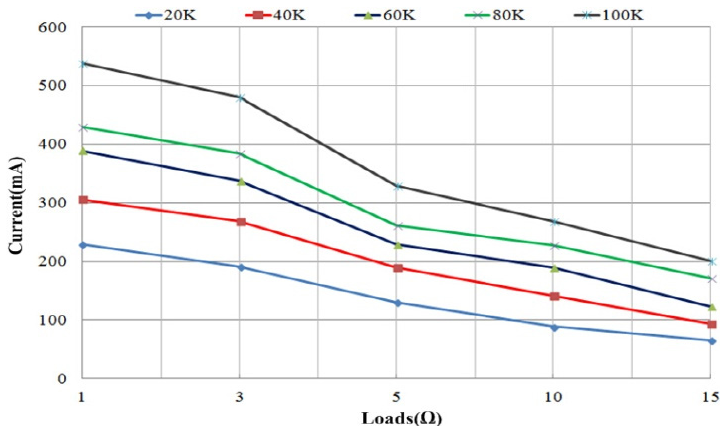
Figure 4. Measured results of the output current versus different loads of TEG module in five temperature difference situations.